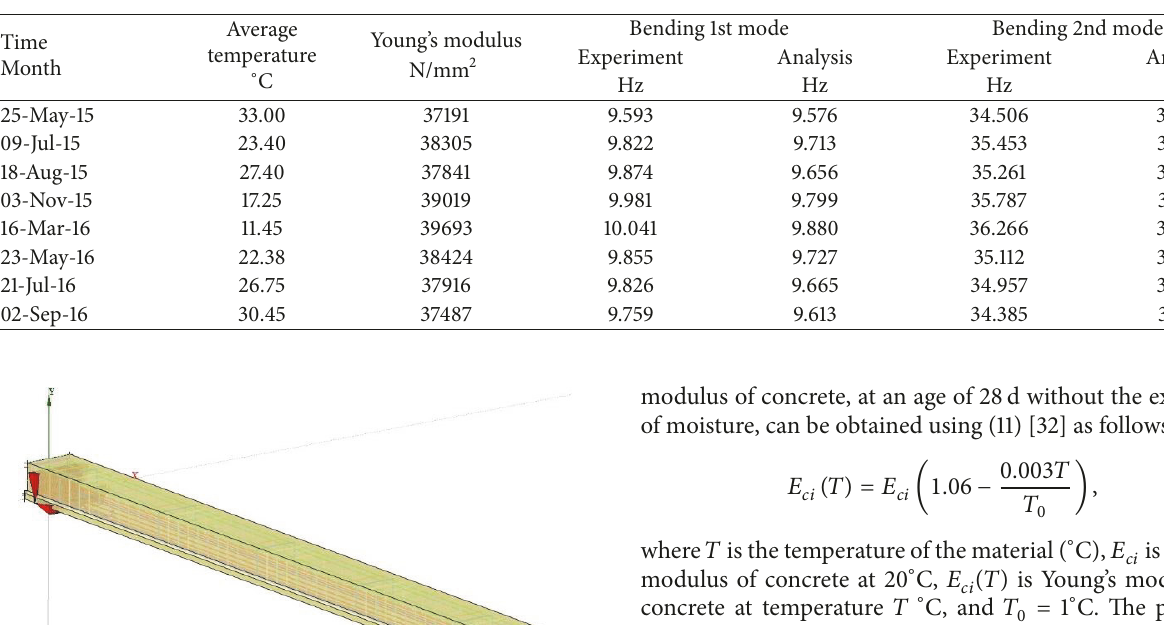
Table 14: Numerical analysis and measured results of two bending modal frequencies.